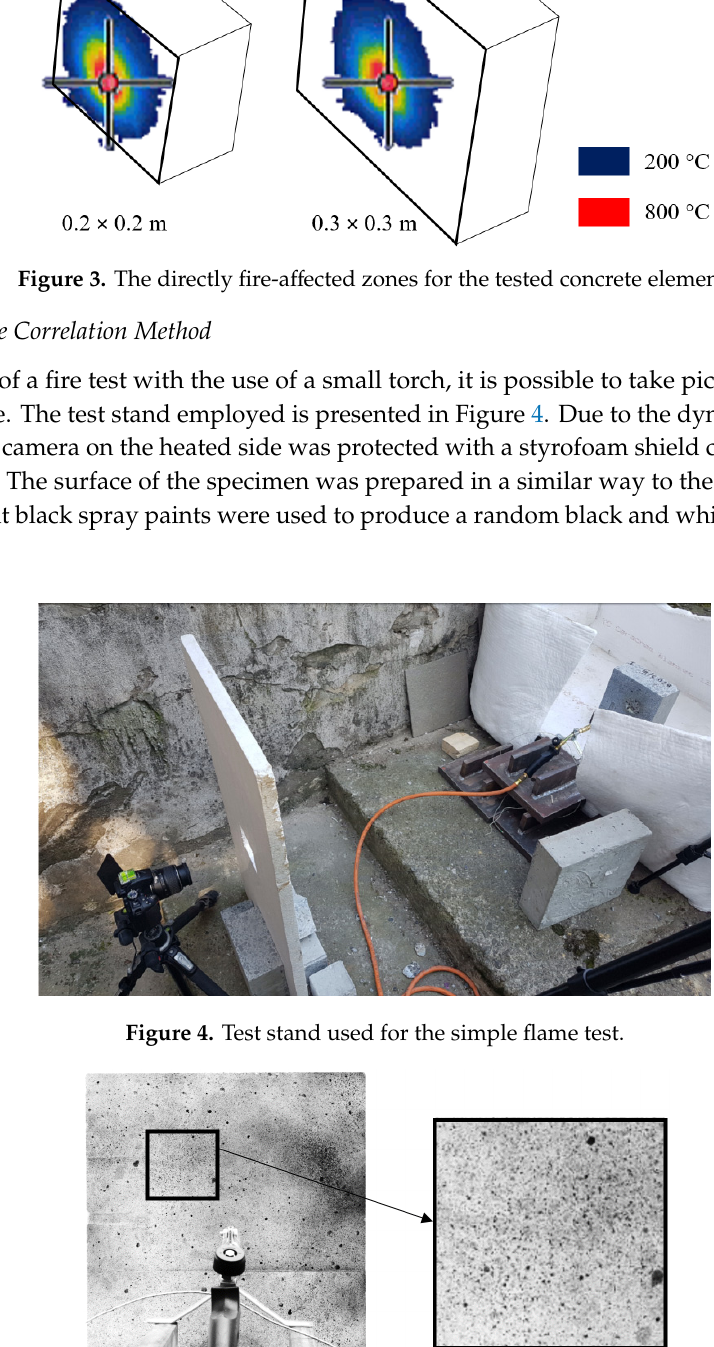
Figure 3. The directly fire-affected zones for the tested concrete element.